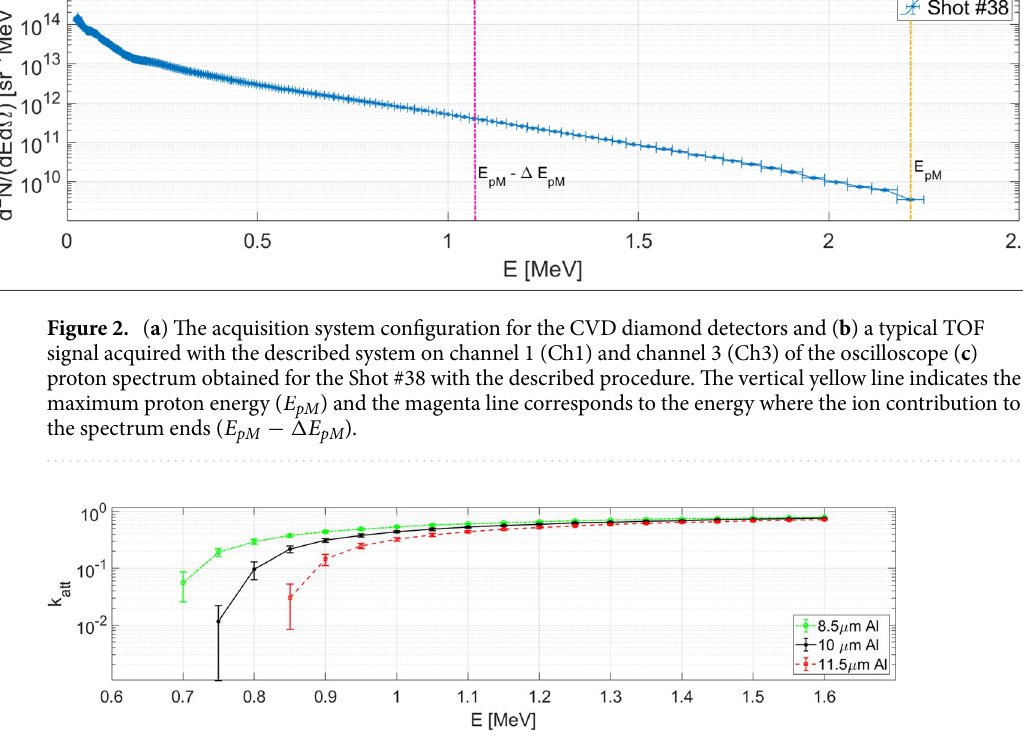
Figure 3. Attenuation factor k att for the (10 ± 1.5) µm Aluminium filter obtained from SRIM simulations, in particular for its nominal value of 10 µm, and for the two extremes of the interval: 8.5 µm and 11.5